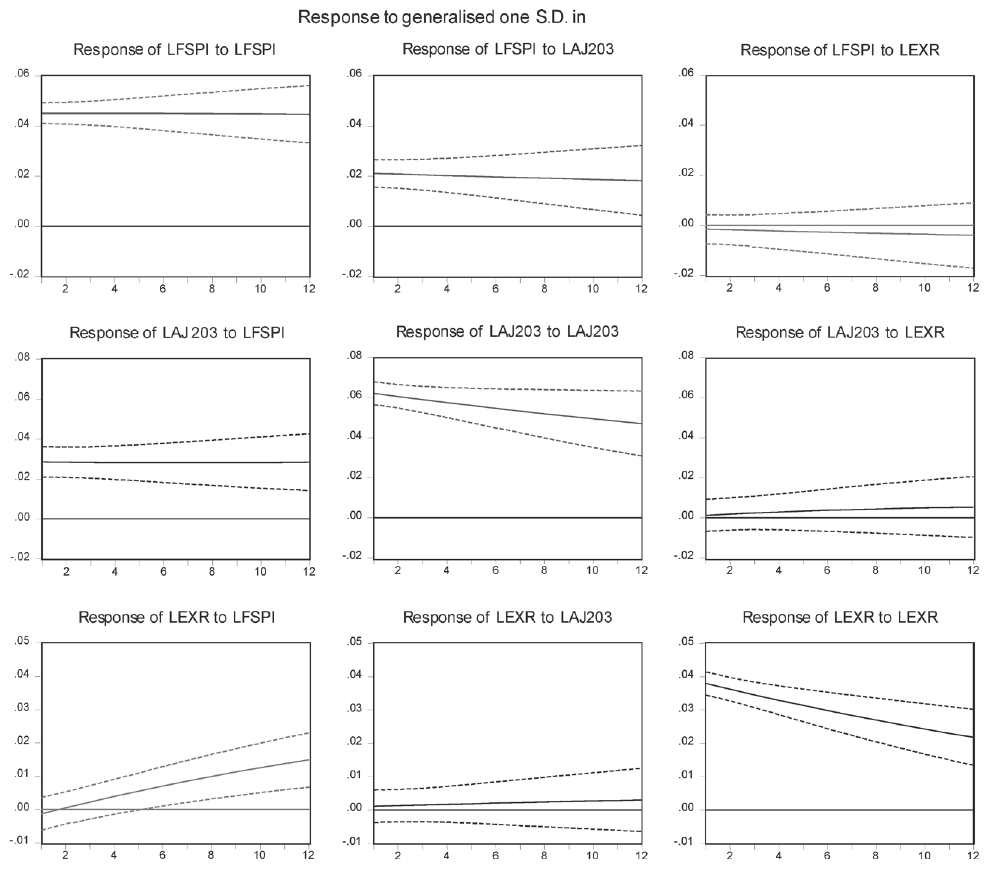
Generalised-impulse response functions [LFSP = S&P 500 stock price index; LEXR = rand/US$ exchange rate; LAJ203 = JSE all share